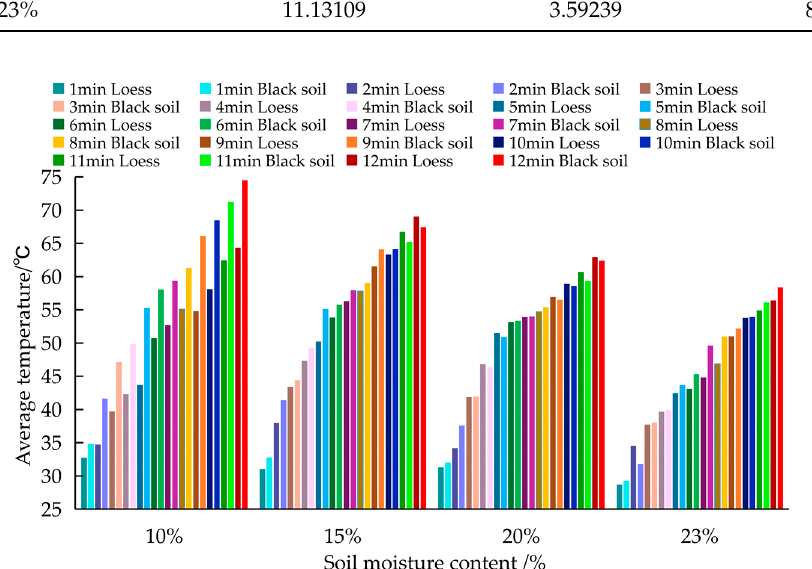
Figure 30. Average soil temperature ( ⎯ T α ) in the microwave-irradiated area of the soil. The microwave irradiation time and soil moisture content were used as independent variables, and the average soil temperature ⎯ T α in the irradiation area was used as the dependent variable to draw a three-dimensional surface; the surface equation is shown in Table 5. Figure 31 shows the soil internal temperature when the moisture content of loess and black soil is 10%, 15%, 20% and 23% after microwave irradiation for 1~12 min. Among them, in the 12 min irradiation condition, the maximum temperature of loess in the microwave irradiation range is 69 ◦ C (with a soil moisture content of 20%) and the average maximum temperature of black soil is 74 ◦ C (with a soil moisture content of 10%) To explore the variation law of the internal temperature of the irradiated area of the soil with the irradiation time and soil moisture content, the three-dimensional surface given in Figure 31 was fitted, as shown in Figure 32; the corresponding fitting surface equation is given in Table 4. The temperature fitting surface of “irradiation time–soil depth” obtained above is the same as the temperature fitting surface of loess “irradiation time–soil water content”, which satisfies the same Gaussian mathematical model.